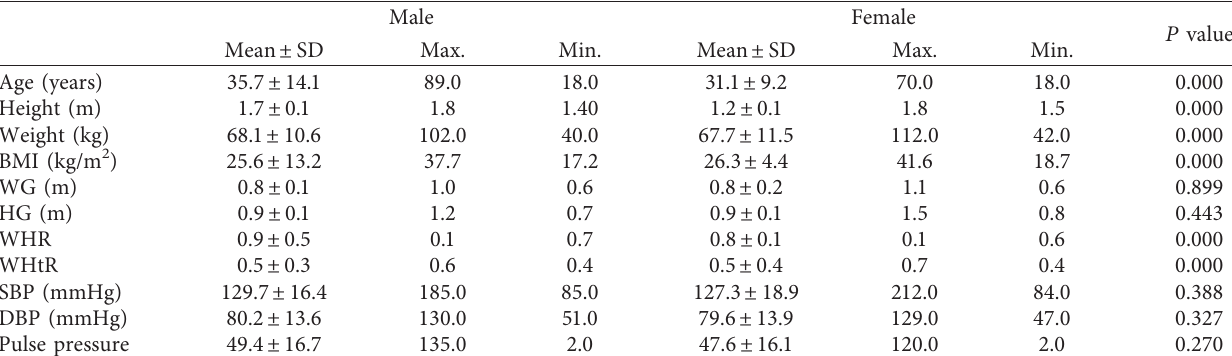
Table 2: Descriptive statistics of male and female anthropometric and blood pressure parameters of rural dwellers of Afikpo community, Ebonyi State, Nigeria.